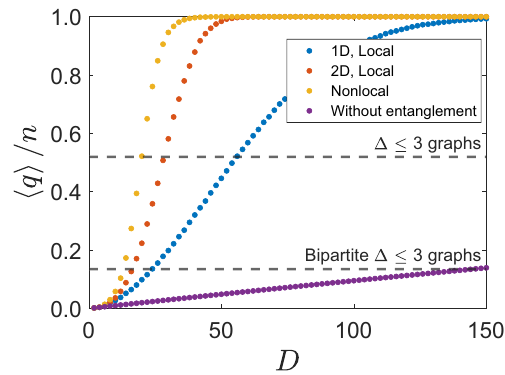
FIG. 3. We represent the expectation value of the fraction of depolarized qubits, (cid:13) q (cid:2) / n , as a function of the circuit depth for the different architectures: 1D, 2D, and nonlocal. We use a system size n = 900 and an error rate p = 10 − 3 . Additionally, we repre- sent (cid:13) q (cid:2) / n = 1 − ( 1 − p ) D , which is the number of depolarized